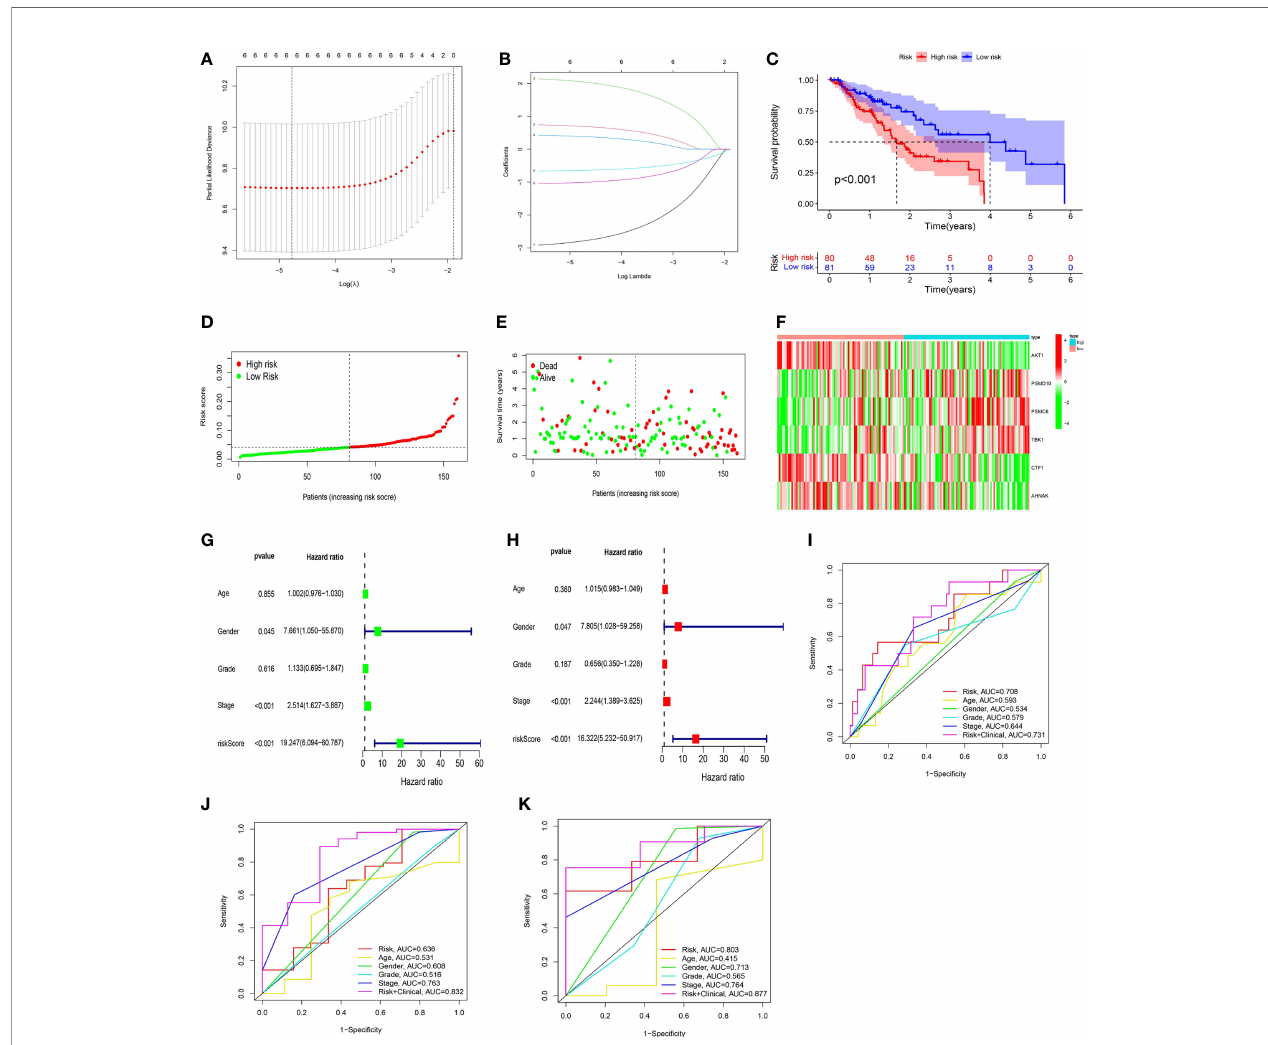
FIGURE 6 | The development of a risk scoring model. (A, B) LASSO regression analysis was used to create a risk scoring model that worked best when all 6 immune genes were included in the model. (C) The low-risk group had a higher overall survival rate than the high-risk group ( P < 0.001). (D, E) On the risk curve, a higher risk score indicated a shorter survival time and a higher mortality rate. (F) In the high-risk group, the expression levels of PSMD10 , PSMC6 , and TBK1 were upregulated, and the expression levels of AKT1 , CTF1 , and AHNAK were downregulated. (G, H) Cox regression (univariate and multivariate) analysis indicated that gender ( P = 0.047, HR = 7.805), stage ( P < 0.001, HR = 2.244), and risk score ( P < 0.001, HR = 16.322) could be utilized as independent prognostic markers for ESCC patients (using OS data). (I – K) The risk score ’ s accuracy in predicting prognosis was assessed using ROC curves (I: 1-year; J: 3-year; K: